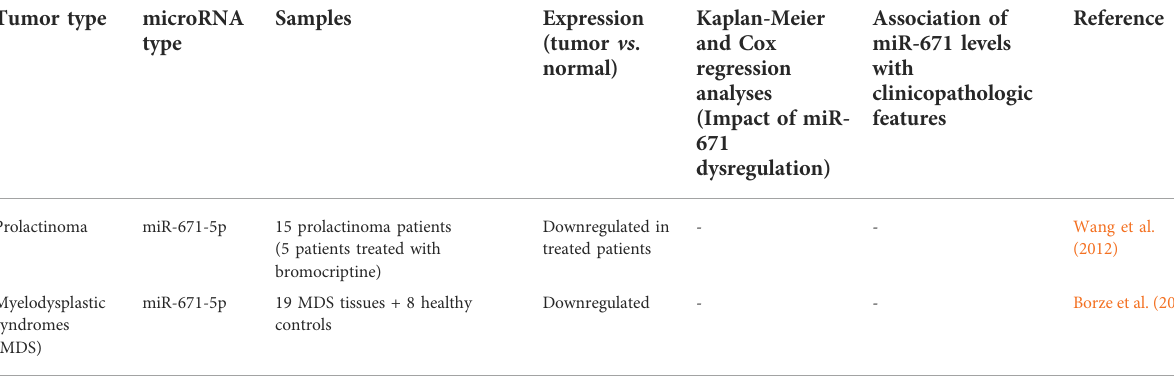
(Figure 3) (Deng et al., 2022). Moreover, miR-671-5p could attenuates neuroin fl ammation through suppression of NF- κ B levels (Deng et al.,